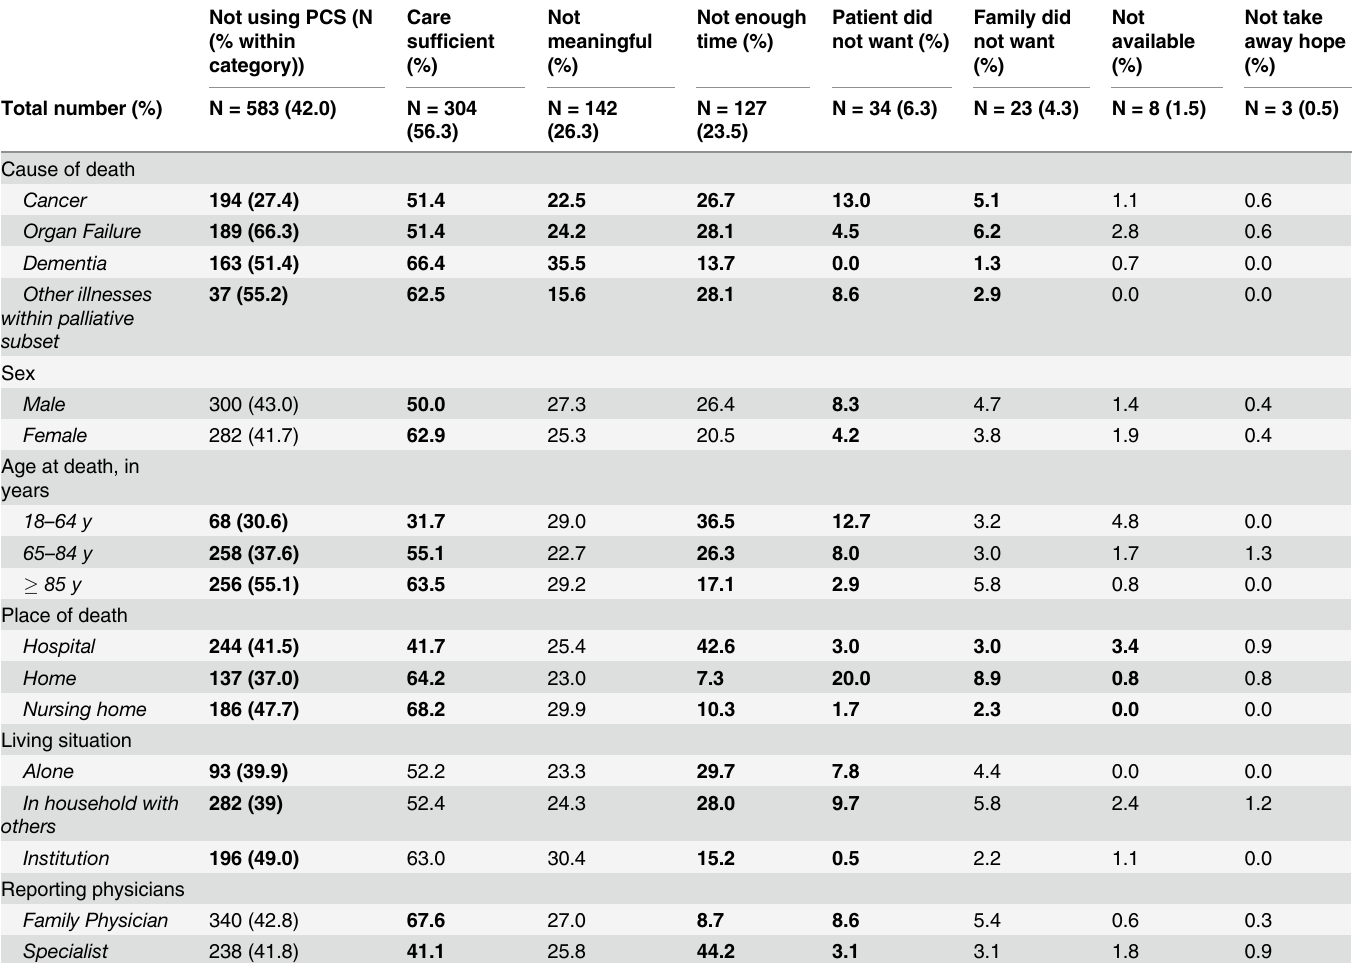
Table 3. Reasons given by physicians for not using palliative care services (PCS) in people with an illness indicative of palliative care need and who died non-suddenly * . Not using PCS (N (%